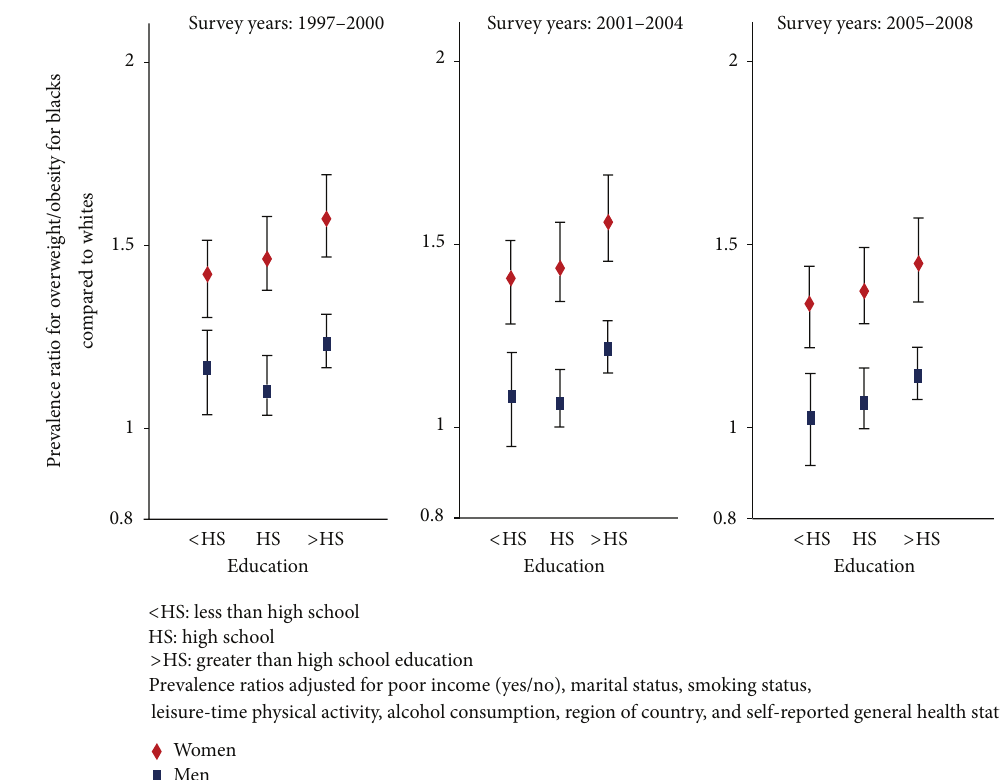
Figure 3: Adjusted prevalence ratios on a log scale for overweight/obesity for blacks compared to whites by sex and educational attainment in 1997 to 2000, 2001 to 2004, and 2005 to